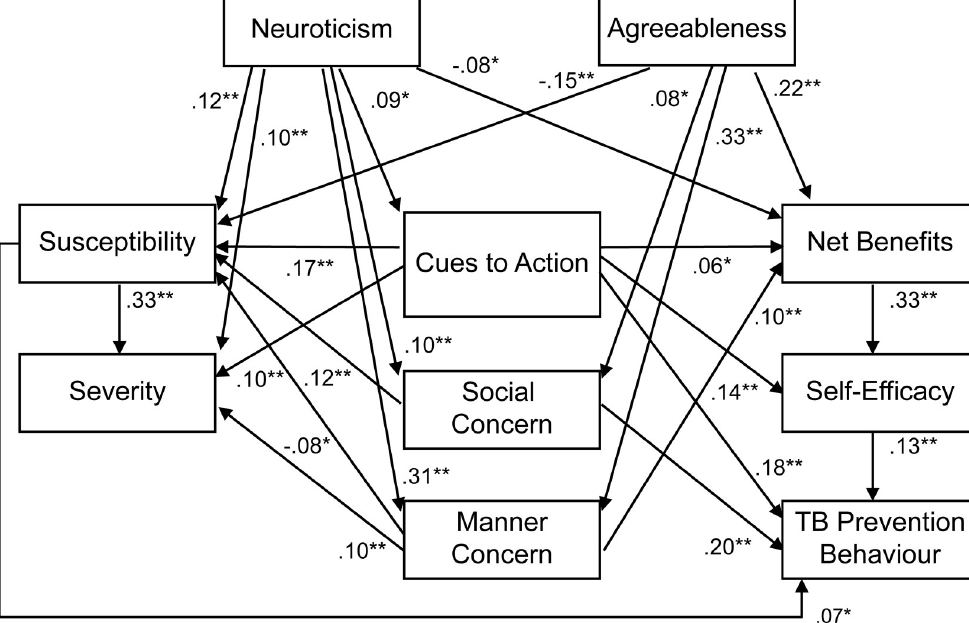
Fig 2. Estimation of the hypothesized health belief model for TB prevention behavior in Japanese adults. χ 2 ( df ) = 6.64 (4), p = .16, CFI = 1.00, RMSEA = .03. �� p < .01. � p < .05. Control paths by age, gender and educational level, covariance between error terms as well as non-significant paths are